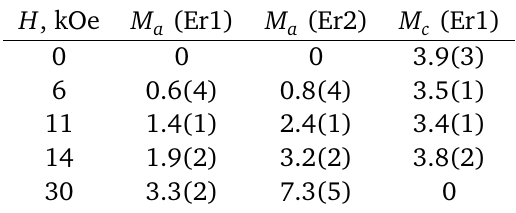
Table 1: Refined magnetic moment components M of the Er1 and Er2 sites as a func- tion of applied magnetic field, H (cid:107) a . Note that the M netic component derived from the q = 0 reflections. The M the amplitude of the long-range antiferromagnetic structure in zero field, in which only the Er1 site is